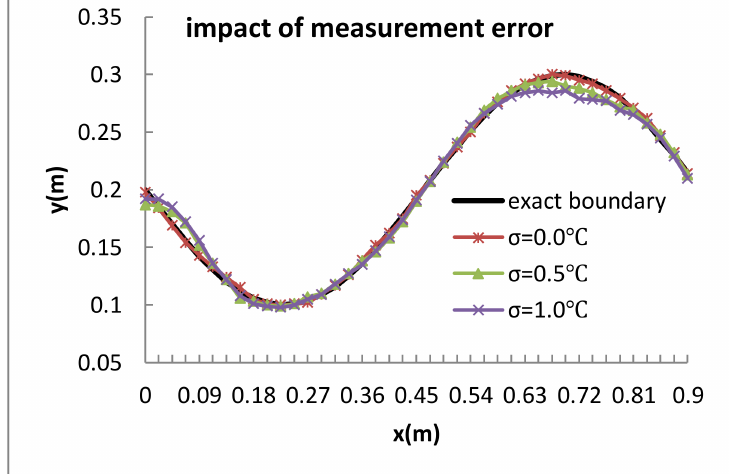
Figure 9. Identification results of di ff erent measurement errors for inversion results of case